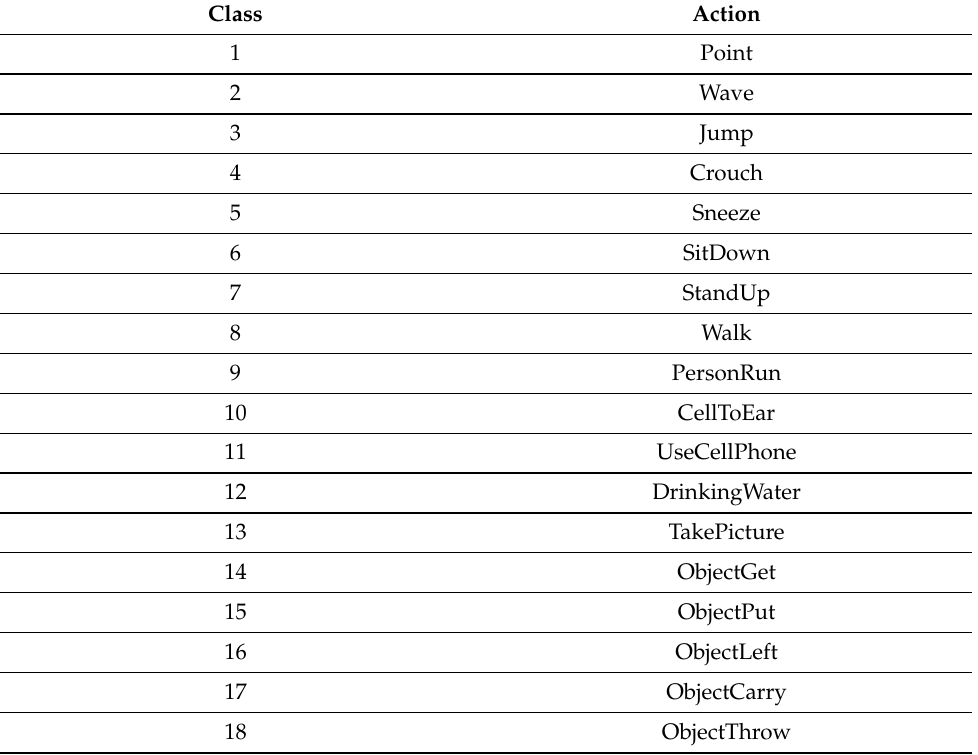
Table 2. List of actions from MCAD